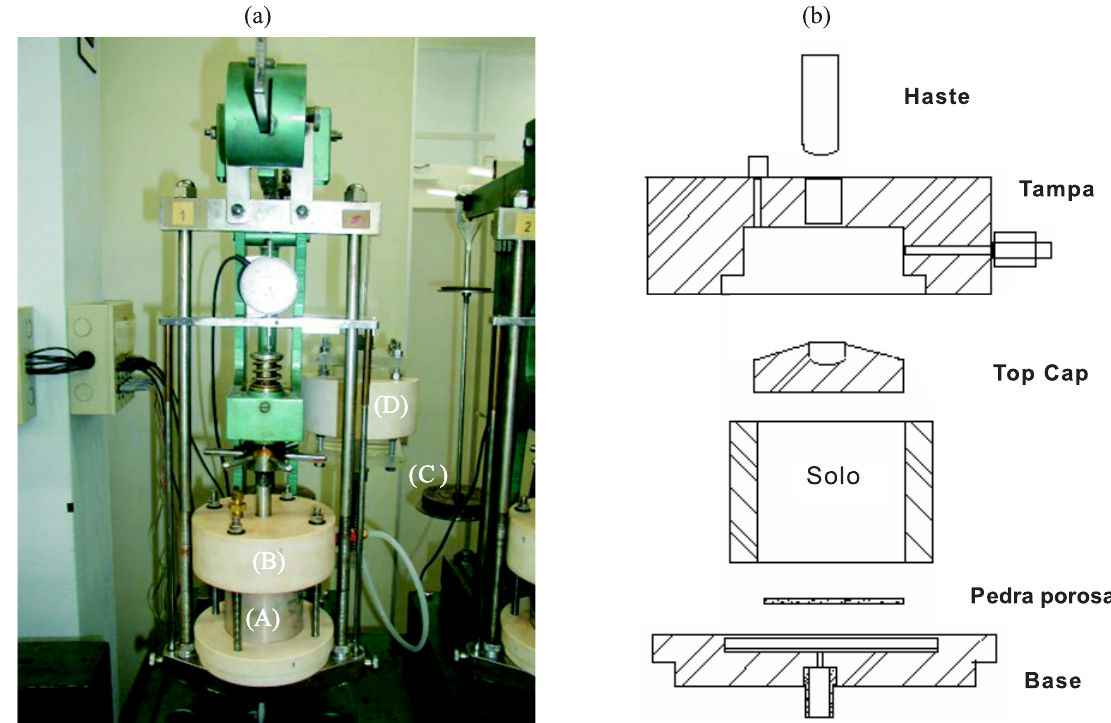
Figura 1. (a) Célula de adensamento montada; (b) seção transversal da célula de